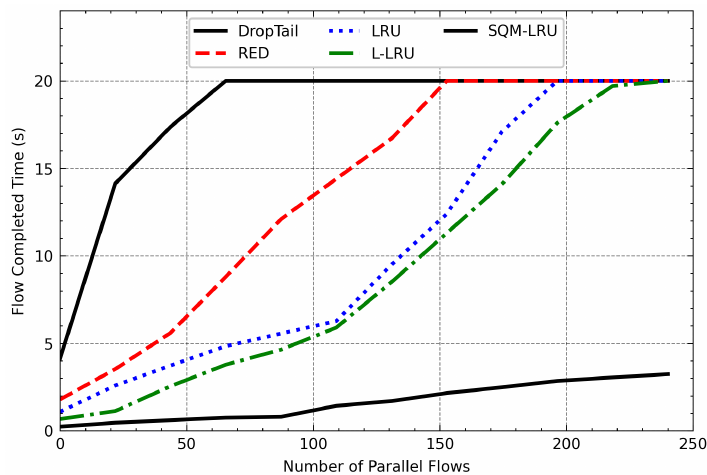
Figure 17. The FCT of Telnet varies with the number of parallel